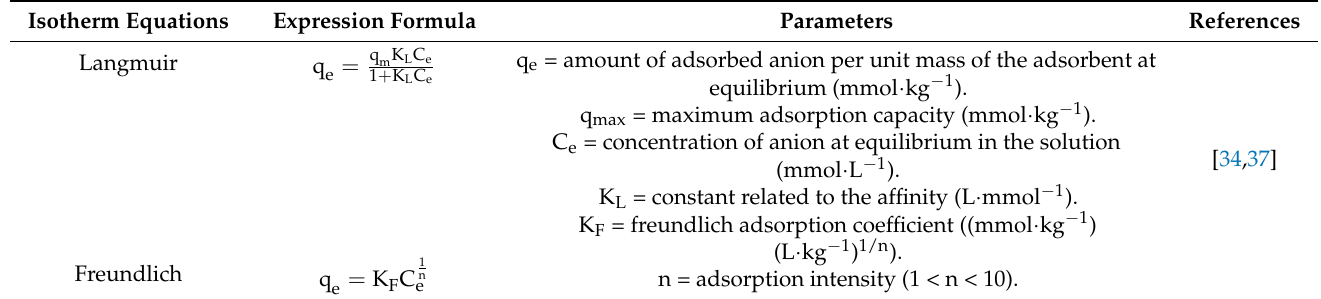
Table 2. The isotherm models used for the description of phosphate